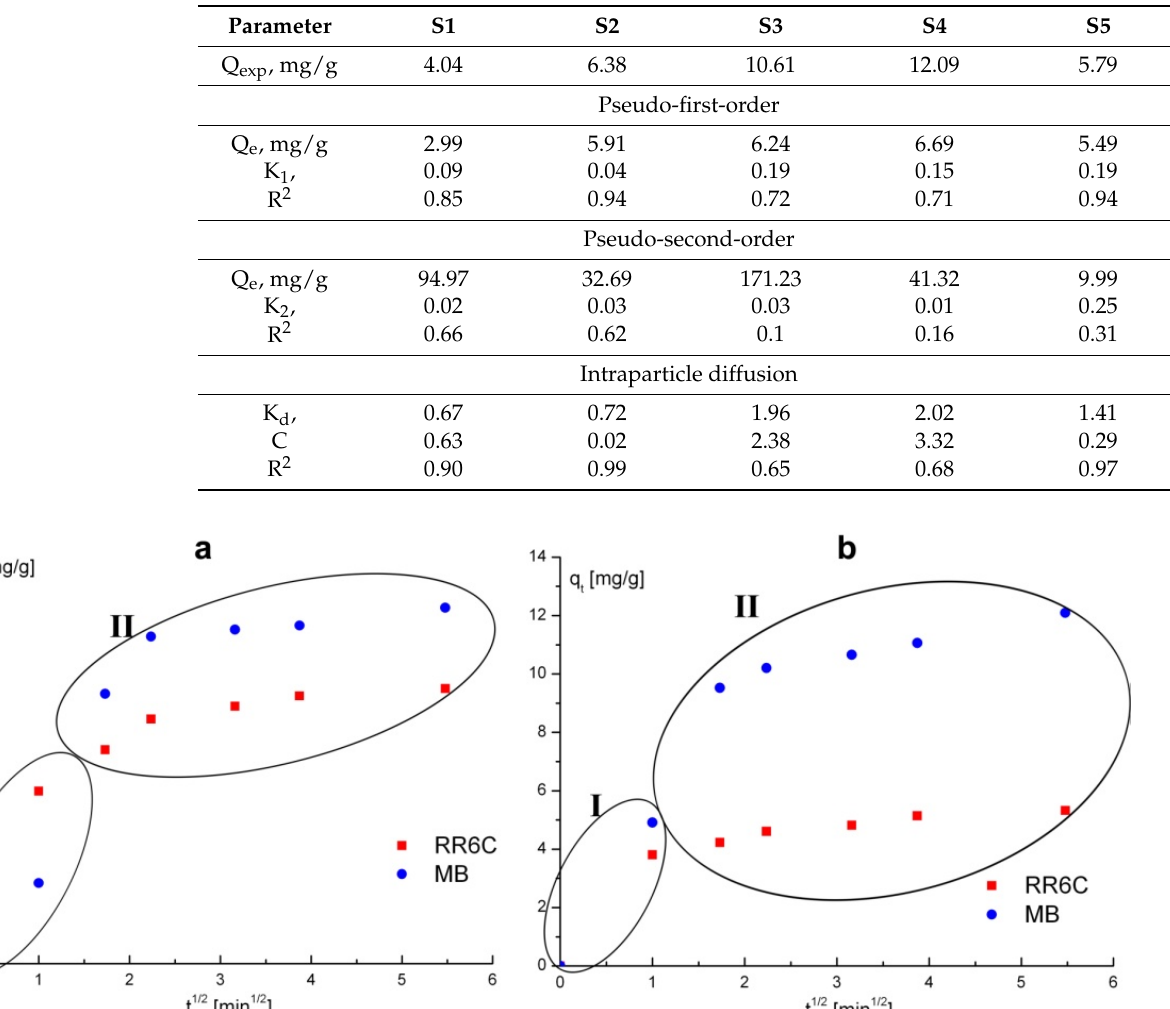
Table 6. Kinetics parameters of Methylene Blue dye sorption onto obtained samples.